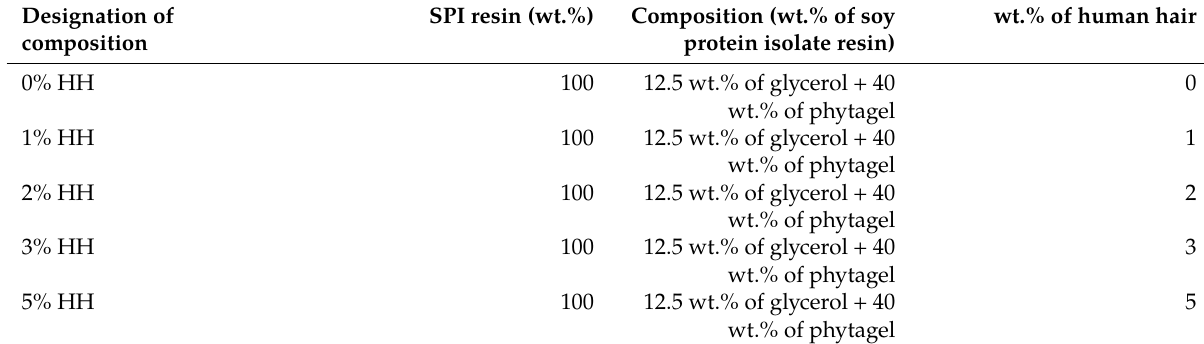
Table 1: Compositions of different wt.% of human hair (HH) reinforced SPI